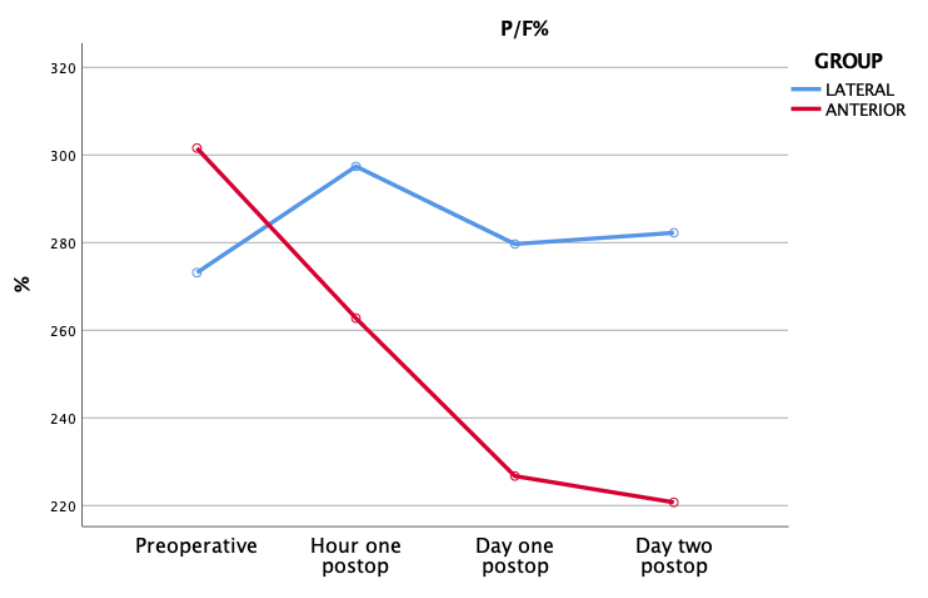
Figure 2. P/F within each study group.